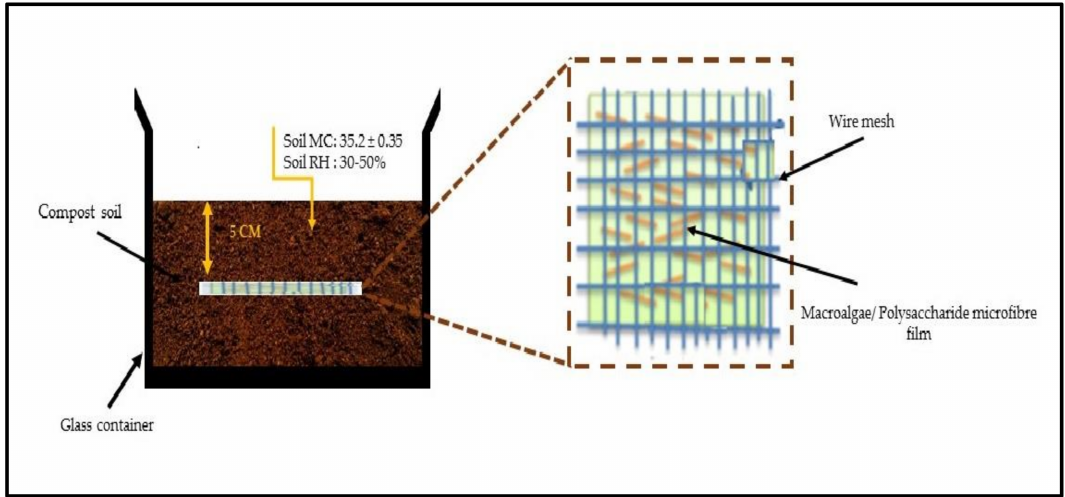
Figure 1. Illustrative diagram soil burial test of macroalgae (SW) / polysaccharide microfibre (GL-MCC)